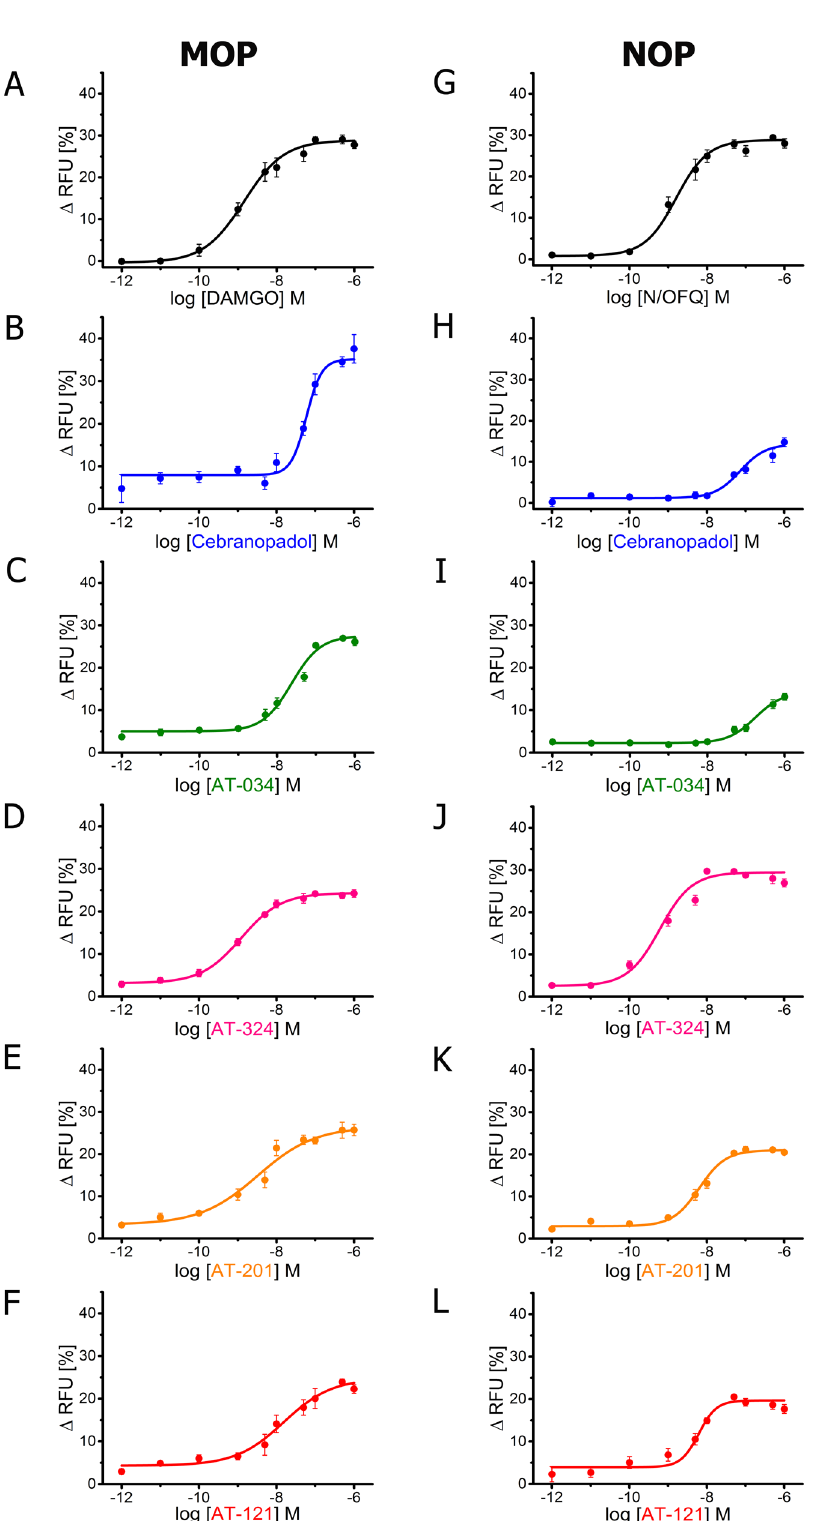
Figure 3. G protein mediated effects of chemically diverse mixed MOP/NOP agonists using GIRK assay. Concentration–response curves obtained for prototypical selective agonist DAMGO ( A ) and N/OFQ ( G ), novel mixed MOP/NOP agonists cebranopadol ( B , H ), AT-034 ( C , I ), AT-324 ( D , J ), AT-201 ( E , K ), AT-121 ( F , L ) at MOP and NOP, respectively. AtT-20 cells stably expressing MOP and NOP were stimulated with the agonists at a concentration range of 10 –6 to 10 –12 M and the signal was measured using GIRK channel-based membrane potential assay. Each data point (mean ± SEM) represents assay read-out obtained from four different experiments in duplicates. (ΔRFU, change in relative fluorescence